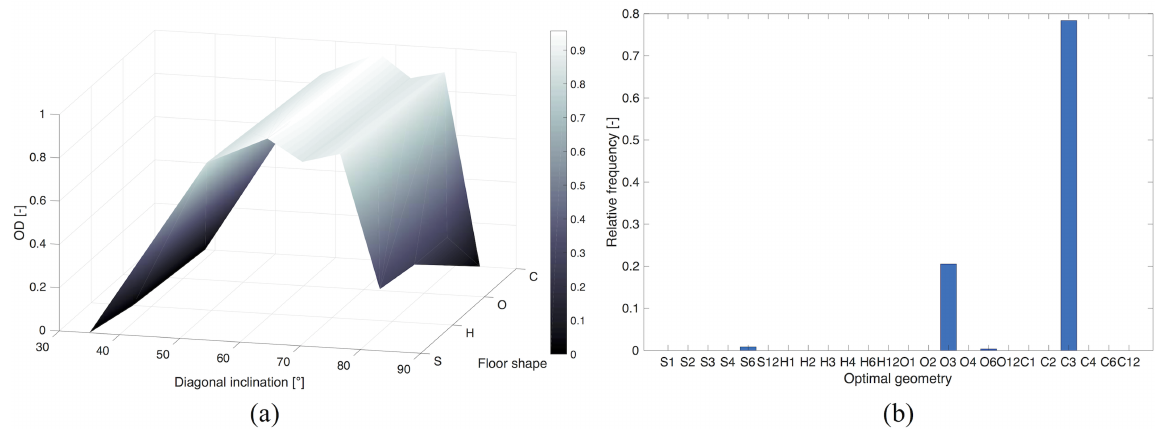
Figure 7: Results for the 210-meter tall building: (a) surface representation of the OD with respect to the diagrid geometrical parameters obtained with r δ = r ϕ = r M = r CI = 1.00 ; (b) optimal diagrid geometry based on 4096 simulations with different exponents r p